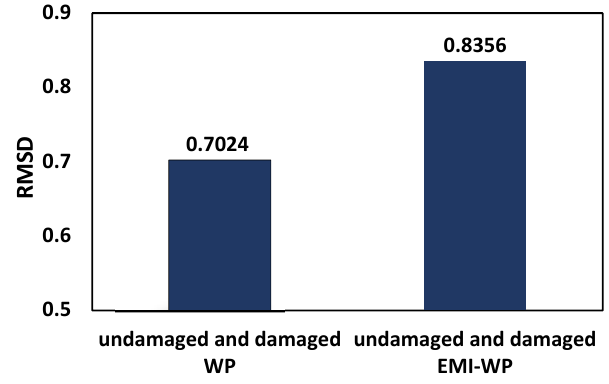
Figure 23. RMSD plot for a concrete beam under different structural conditions.